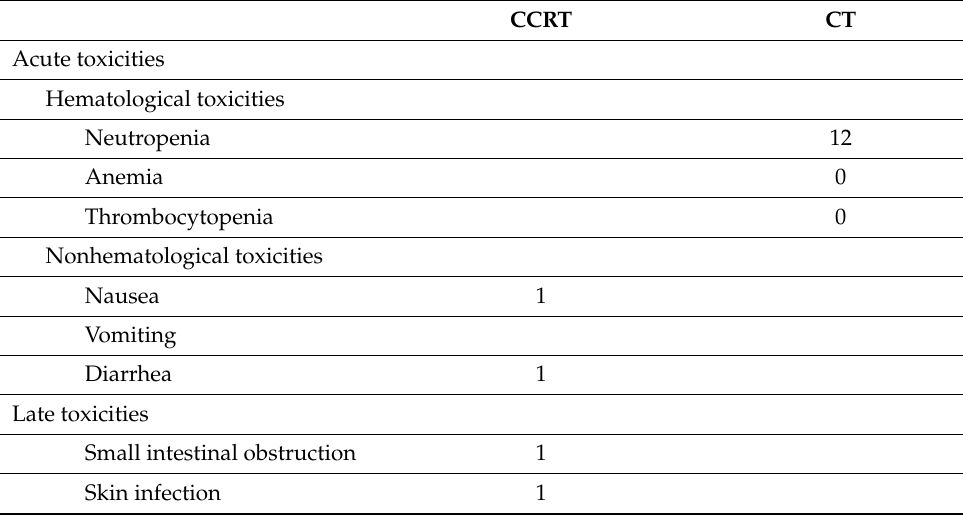
Table 3. Adverse events